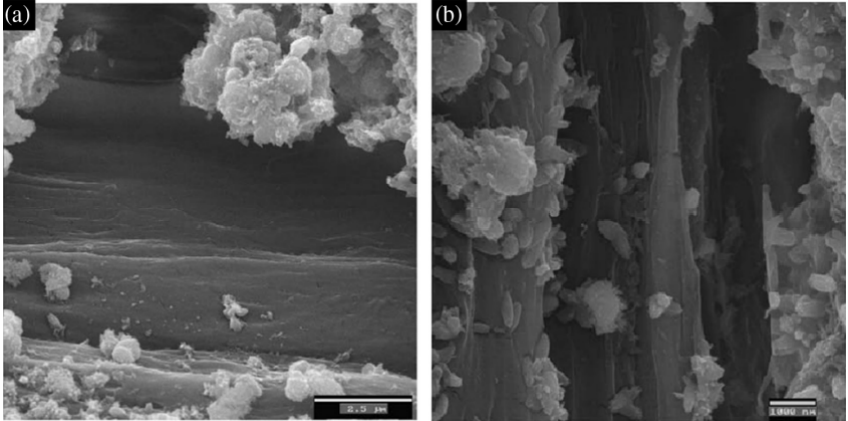
Figure 11. The surface of polypropylene fibres: before alkaline treatment ( a ) and after alkaline treatment ( b ) [128].